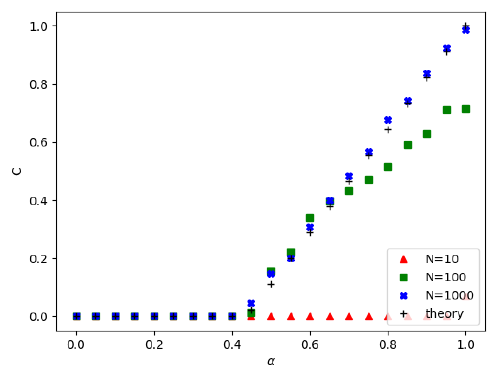
Figure 11. Comparison of concurrence: σ = 1.